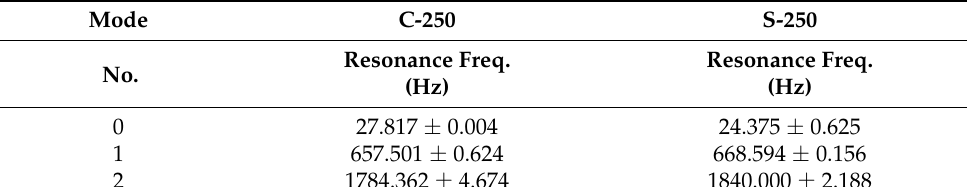
Table 10. Identified natural frequencies for the 250 mm-length.